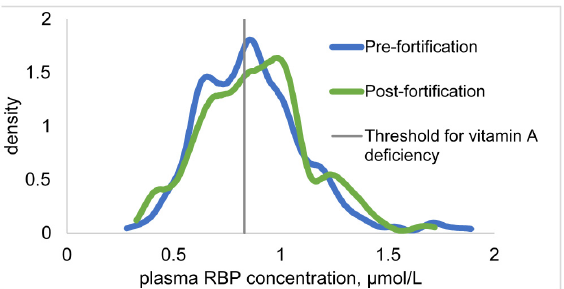
Figure 1. Kernel density distributions of plasma retinol-binding protein (RBP) concentrations (unadjusted for inflammation) among children 12–59 months of age in Yaoundé and Douala, Cameroon, two years before and one year after the introduction of vitamin A-fortified cooking oil through a mandatory national program. Plasma RBP is compared to the cutoff for vitamin A deficiency (0.83 µmol/L, equivalent to 0.70 µmol/L plasma retinol). Nutrients 2017 , 9 , 522